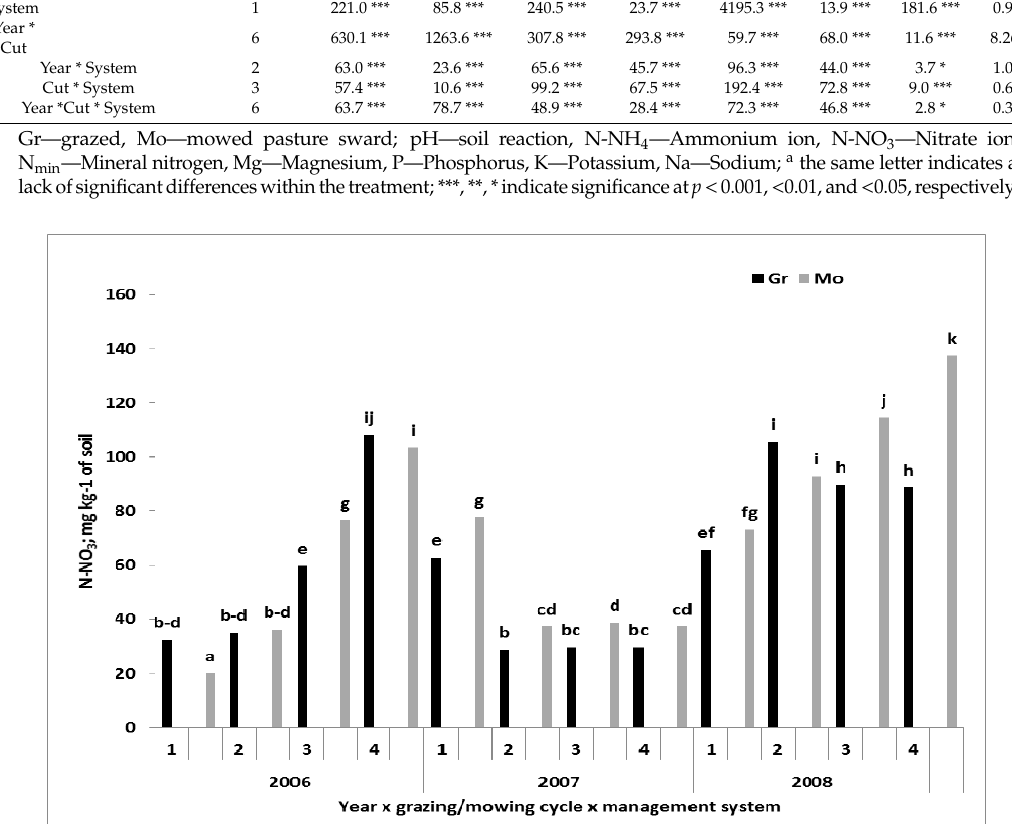
Figure 5. Effect of the grassland management in consecutive cut on ammonium content. a The same letter indicates a lack of significant differences within the treatment ( p < 0.05).